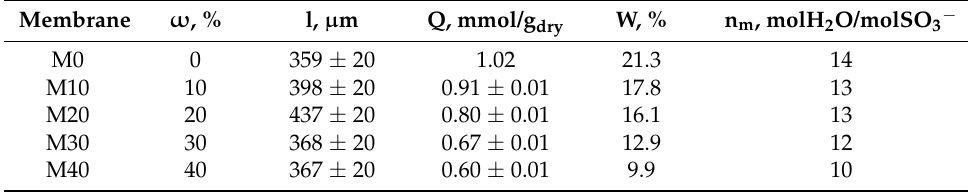
Table 1. Physicochemical characteristics of the membrane samples in Na + -form.